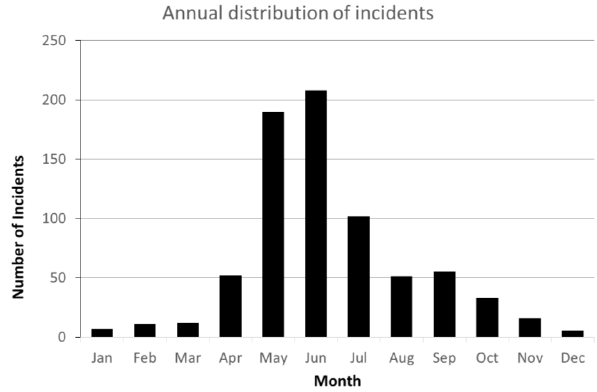
Figure 6. Annual distribution of the total number of lightning inci- dents by month (January 1930 to June 2014).